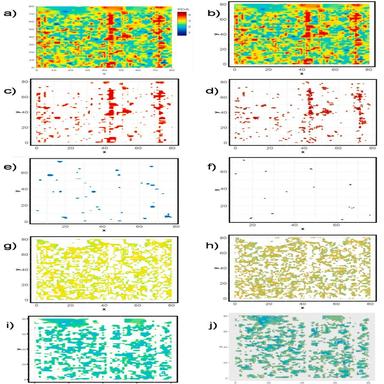
(a) original nanoindentation phase map image, (b) clustered image, (c) nanoindentation martensite map, (d) combined nanoindentation-EBSD martensite map, (e) nanoindentation austenite map, (f) combined nanoindentation-EBSD austenite map, (g) nanoindentation bainite map, (h) combined nanoindentation-EBSD bainite map, (i) nanoindentation ferrite map, (j) combined nanoindentation-EBSD ferrite map. X and Y coordinates are presented in µm.